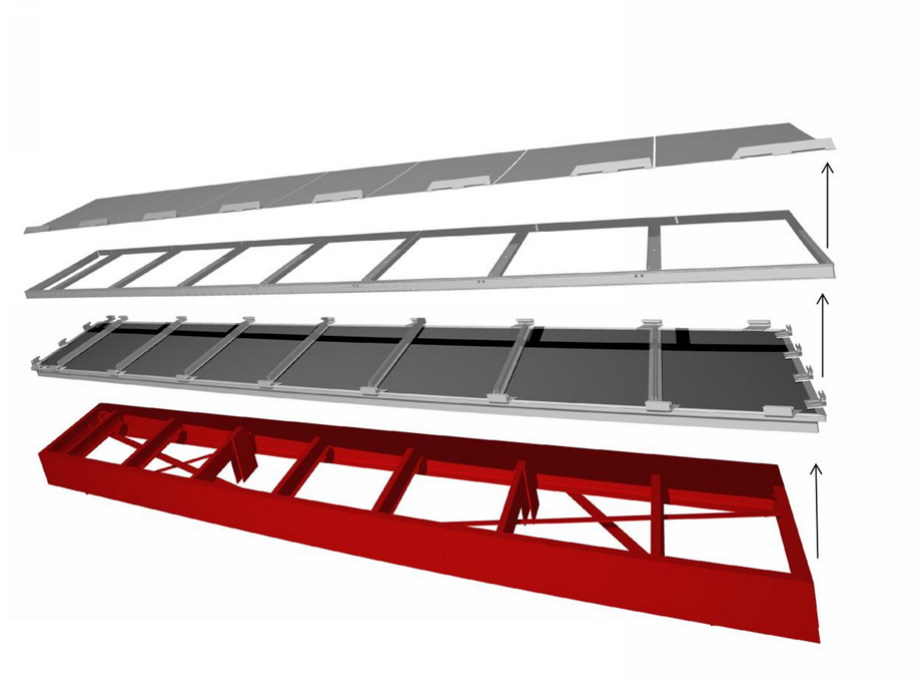
Fig. 5 Sloped Façade Unit Layers